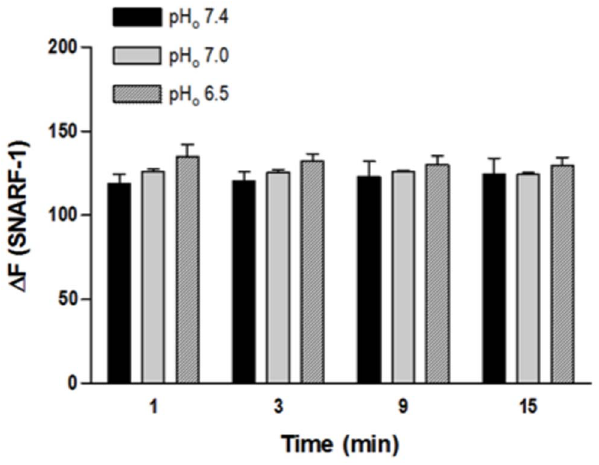
Figure 4. Effect of extracellular acidification on pH i in isolated endothelial cells from rat aorta. Cells were loaded with SNARF-1 (10 m M) and analyzed by flow cytometry. HCl was used to reduce pH o from 7.4 to 7.0 and from 7.4 to 6.5; Hanks solution pH 7.4 served as control. Fluorescence intensity was measured before the HCl stimulus (F 0 ) and at different time points (t=1, 3, 9 and 15 min) after this stimulus (F t ). Results are reported as D F=F t - F 0 . All values are means 6